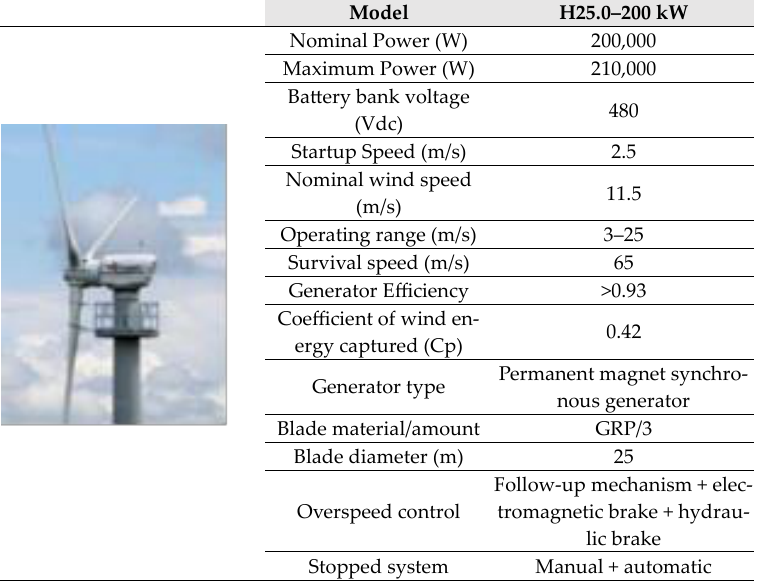
Figure 13. Features of the selected wind turbine (hummer H25.0–200 kW—Livre Power, Lda, http://livre.pt/pt/185-hummer undated, (accessed on 15 May 2022).